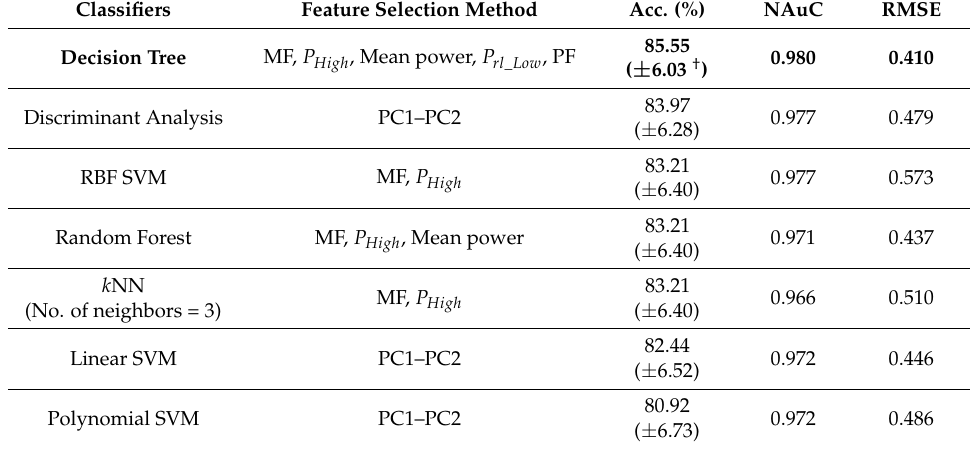
Figure 5. Cumulative distribution functions (CDFs) of the classification error e of each optimized classifier. The thick black line with filled circles is the best result obtained by the decision tree for the PCA-projected data. Table 4. Performance of each optimized classifier *.